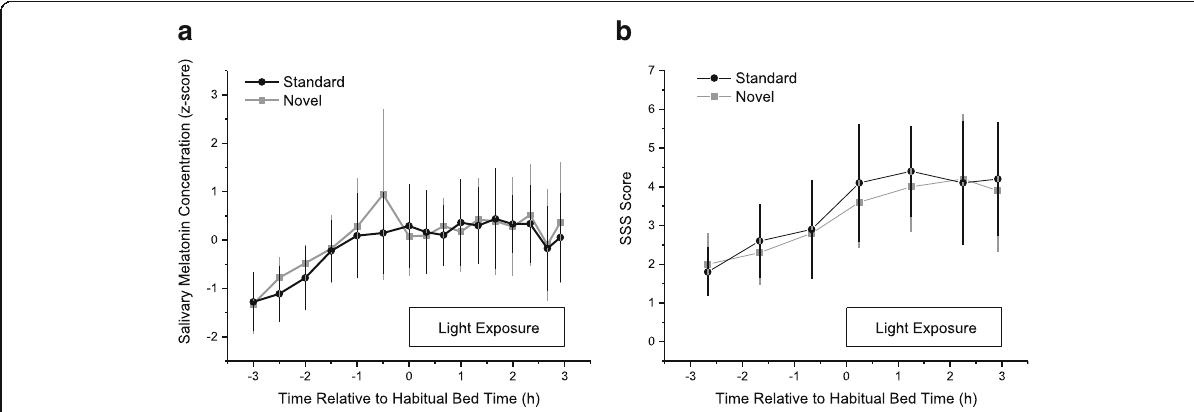
Fig. 3 Changes in salivary melatonin concentration ( a ) and SSS values ( b ) during the baseline (< 10 lx, − 3 → 0 h) and experimental light exposure (150 lx, 0 → 3 h) for both the blue-depleted (grey) and standard (black) white LED lamps. Melatonin data were z-score transformed and averaged prior to plotting. Mean ± SD are